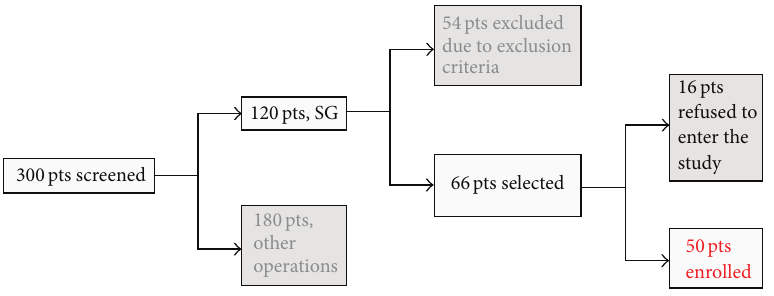
Figure 1: Diagram of patients selection.